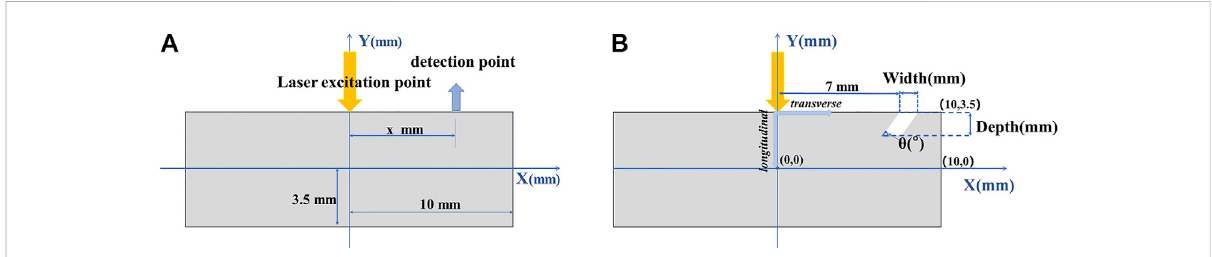
FIGURE 1 Laser ultrasonic detection model: (A) without crack; (B) with angled